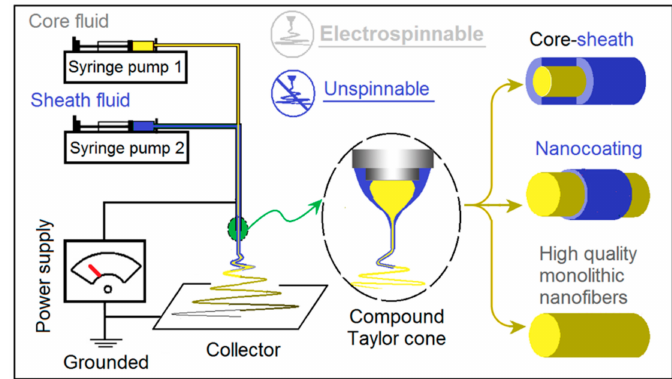
Figure 2. The modified coaxial electrospinning process, which permits a range of novel structures to be obtained through the unspinnable sheath fluid.